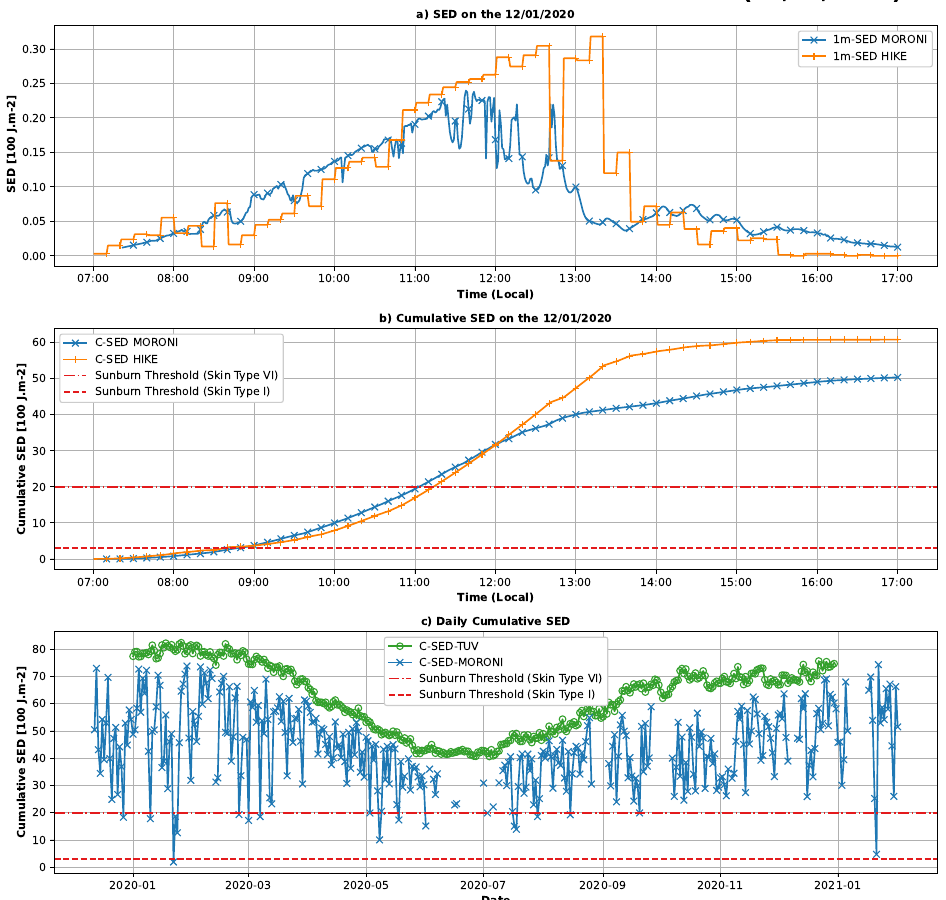
Figure 7. ( a ) Equivalent erythemal doses (erythemal radiant exposure of 100 SED) measured at Moroni and during ascent of Karthala on 12 January 2020. ( b ) Cumulative doses at Moroni (orange) and during ascent of Karthala (blue) on 12 January 2020. Thresholds for phototypes of two erythemal extremes are in red dashed and dash dotted lines (according to Fitzpatrick). ( c ) Daily cumulative erythemal doses: in blue at Moroni (RADIO), and in green at Moroni (TUV). Thresholds for phototypes of two extremes erythema are represented in red (according to Fitzpatrick).